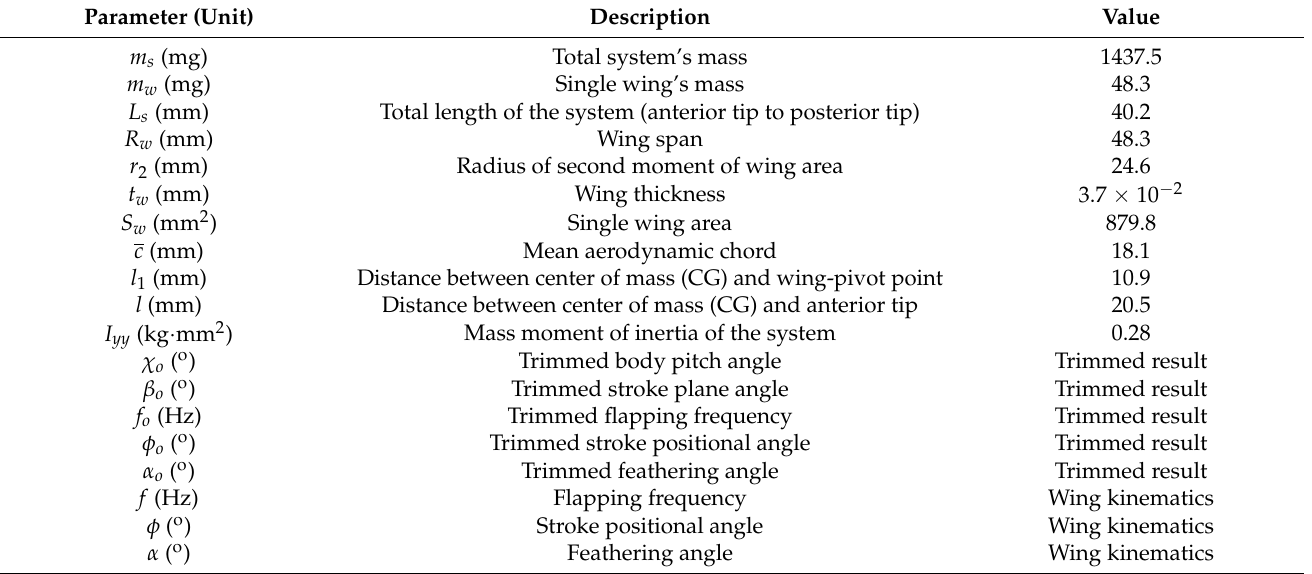
Table 1. Morphological parameters and nomenclature of the reference hawkmoth-like